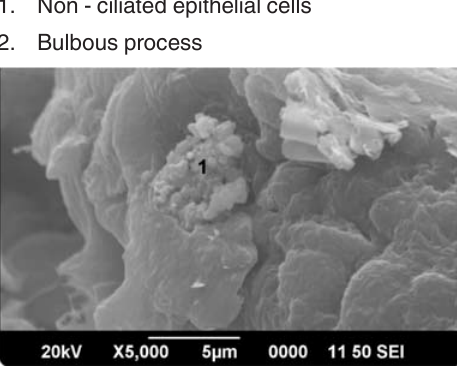
Fig. 6. sEm image of secretory material of the oviductal epithelium. sEm x